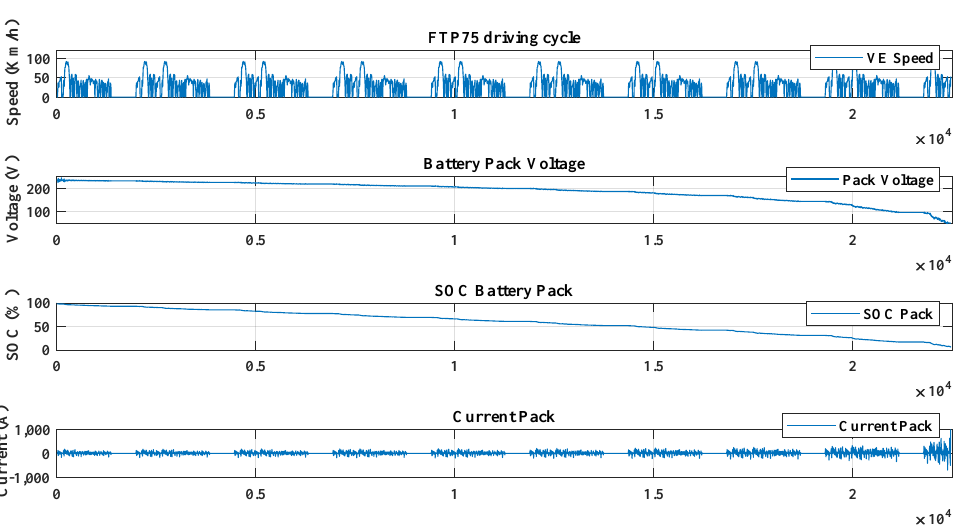
Figure 13. EV model simulation results. The driving cycle is repeated until the battery is fully discharged. EQ is active across stacks and passive at the cell level.